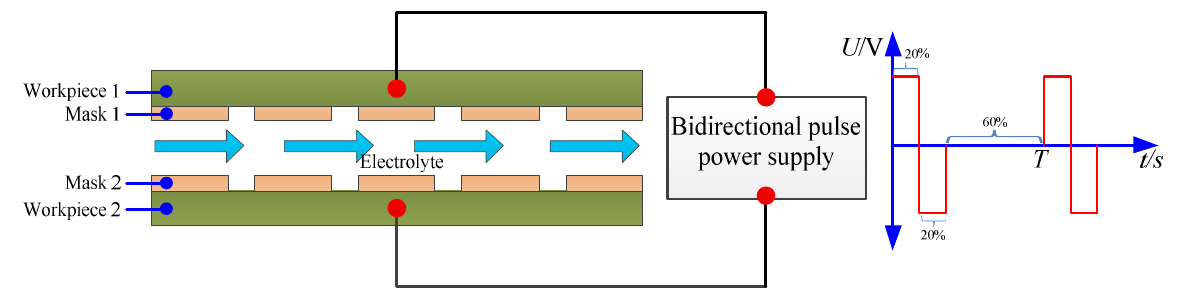
Figure 1. The schematic diagram of bidirectional pulse electrochemical micromachining.